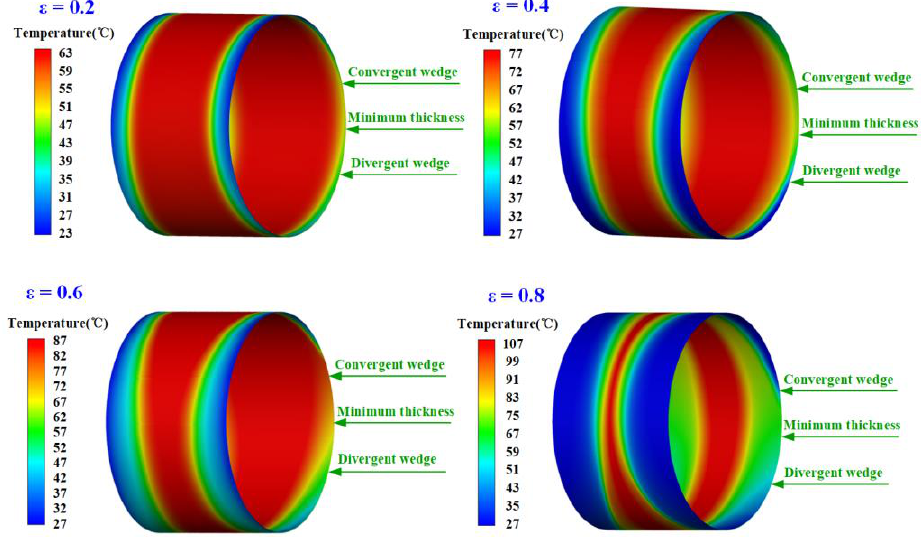
Figure 10. Temperature distribution of magnetic fluid lubrication film.